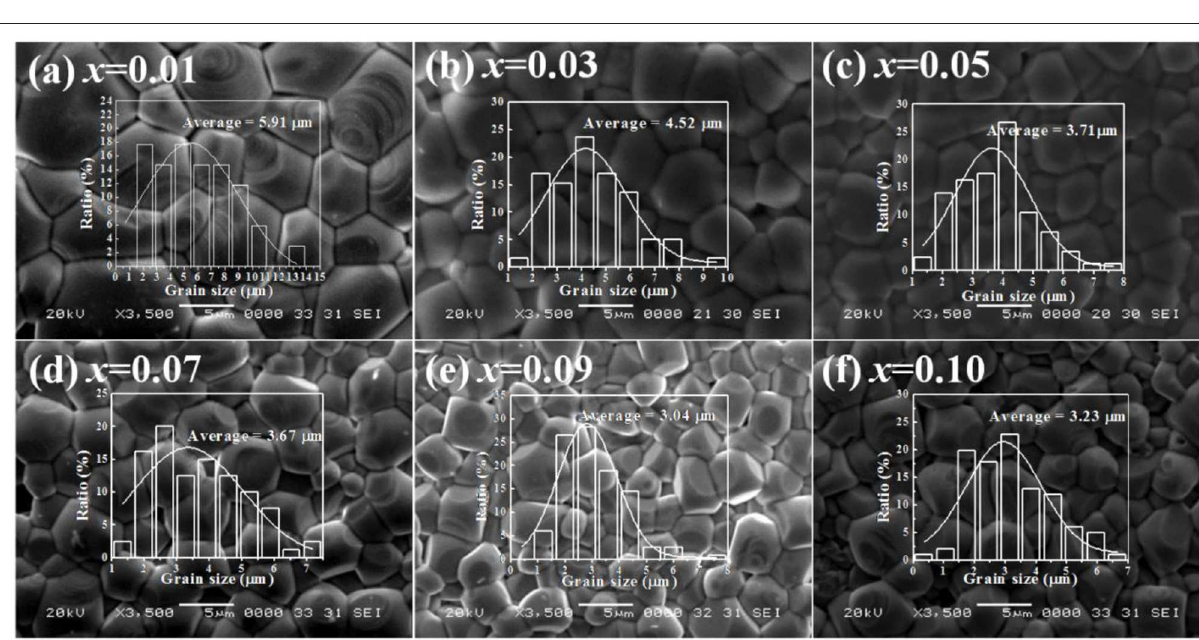
FIGURE 2 | Surface morphology and grain size distribution of BNKT- x FSN ceramics with different FSN contents: (a) 0.01, (b) 0.03, (c) 0.05, (d) 0.07, (e) 0.09, (f)